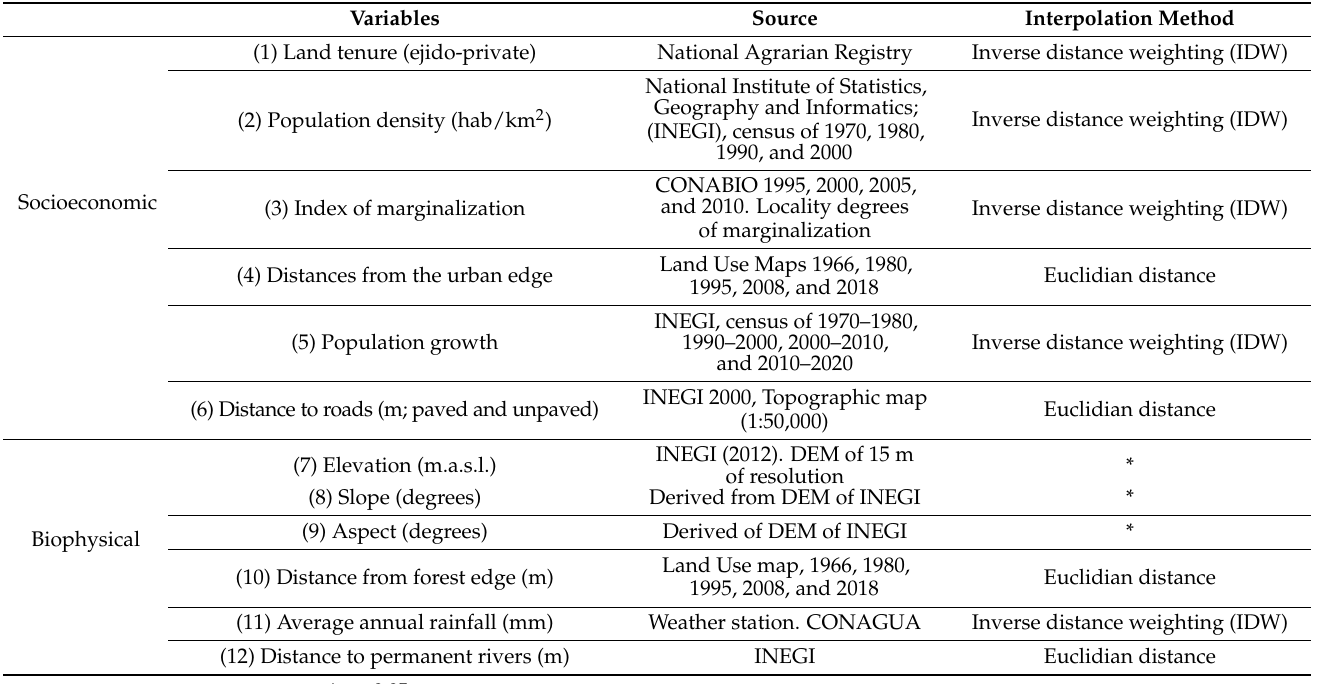
Table 1. Biophysical and socioeconomic explanatory variables used in stepwise logistic regression models explaining patterns of forest cover loss and gain in the peri-urban zone of the city of Xalapa. Variables Source